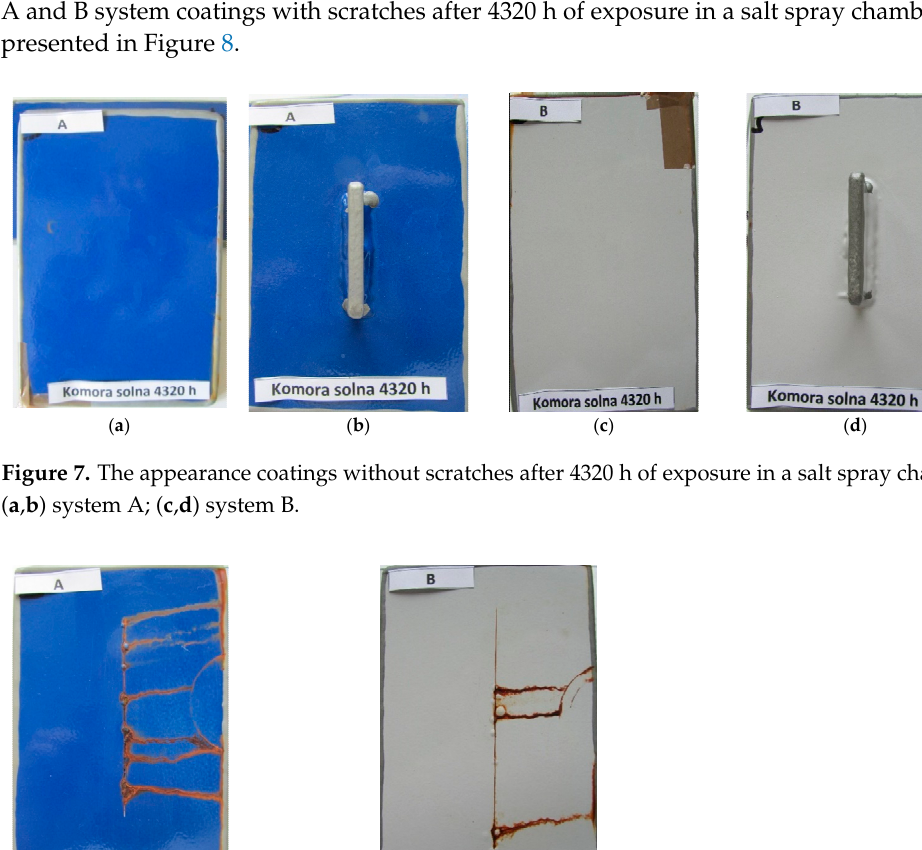
Figure 8. The appearance of coatings with scratches after 4320 h of exposure in a salt spray chamber: ( a ) system A; ( b ) system B. Figure 9 summarizes the measurement results of log|Z| at 0.1 Hz for new systems, for systems after various accelerated tests and for systems on the bridges.